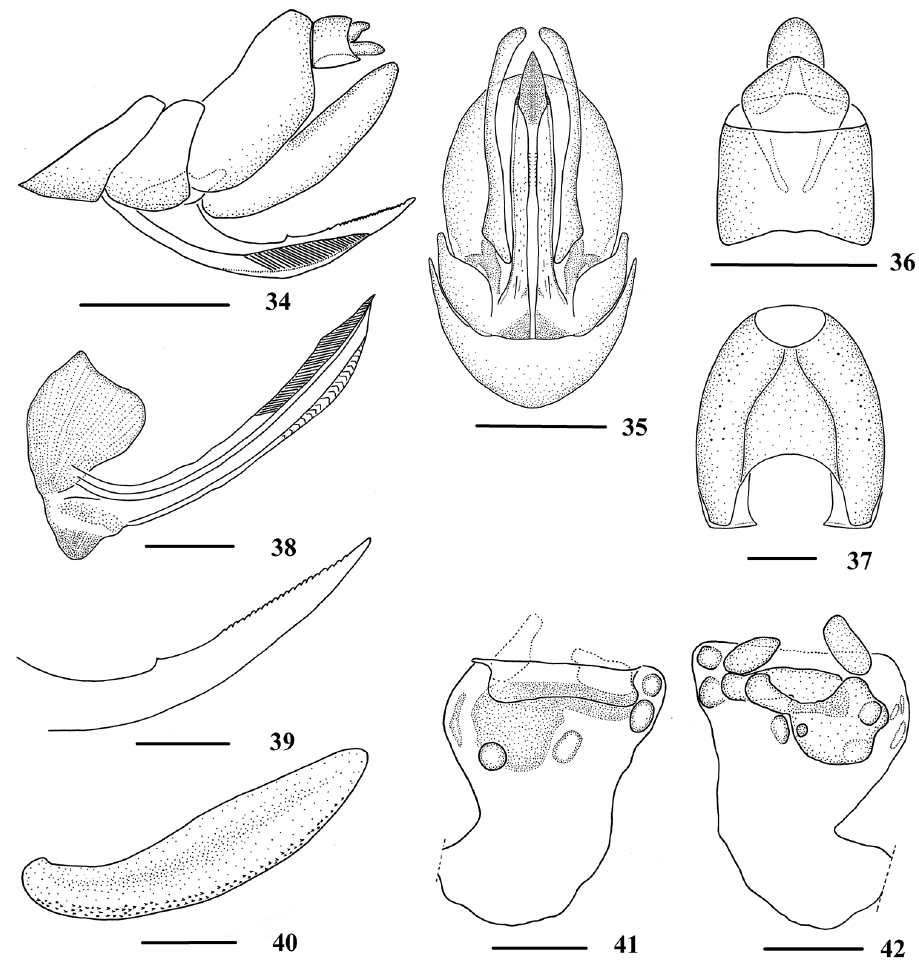
Figures 34–42. Neocarpia hamata Zhang & Chen, 2013, female 34 Genitalia, lateral view 35 Genitalia, ventral view 36 Anal segment, dorsal view 37 Pygofer, caudal view 38 Gonapophysis VIII and gonocoxa VIII, dorsal view 39 Gonapophysis IX, lateral view 40 Gonoplac, inner lateral view 41 Posterior vagina, ventral view 42 Posterior vagina, dorsal view. Scale bars: 0.5 mm ( 34–35 ); 0.2 mm ( 36–42